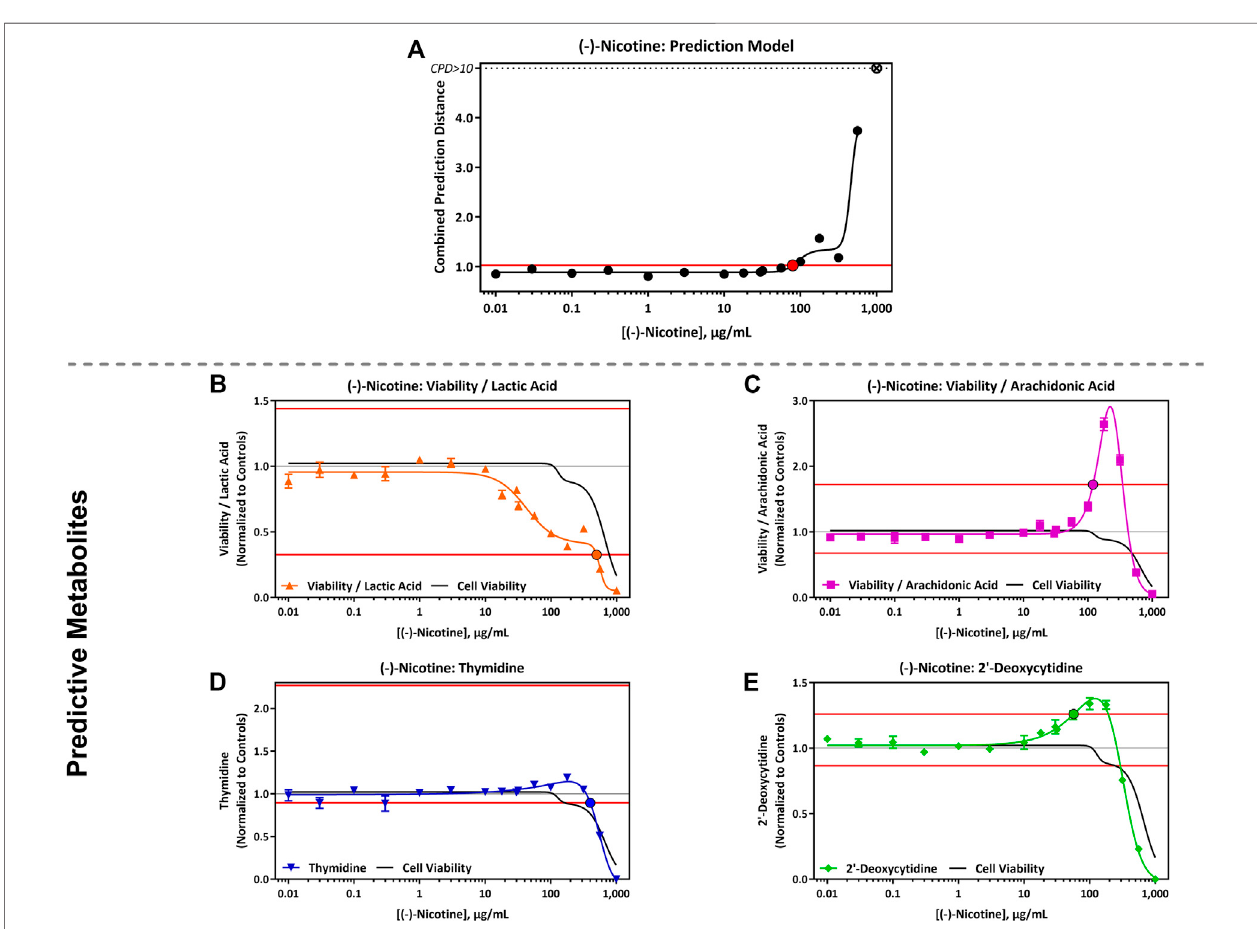
FIGURE 1 | Cardio qP Assay Results Following Exposure to 0.01 – 1,000 μ g/mL (-)-Nicotine. (A) (-)- Nicotine dose-response results for the Cardio qP prediction model. The horizontal red line represents the cardiotoxicity threshold and the red fi lled circle indicates the predicted cardiotoxicity potential concentration (cTP). Concentrations greater than the cTP are predicted to be cardiotoxic. The y-axis is the combined prediction distance, which is determined from each biomarker ratio ’ s responsenormalized toits predictive threshold (level ofchangerequired fora toxic prediction). CPD: Combinedprediction distance; ⊗ :CPD > 10 (B) Change in Cell Viability/Lactic Acid; (C) Cell Viability/Arachidonic Acid; (D) Thymidine, and (E) 2 ′ -Deoxycytidine. The horizontal red lines represents the metabolite-speci fi c prediction thresholds.They-axisisthereferencetreatmentnormalized(foldchange)valueforeachmetabolite/ratio.Theblackborderedcirclesrepresentthenicotineconcentration where the dose-response curve crossed the metabolite-speci fi c prediction threshold.